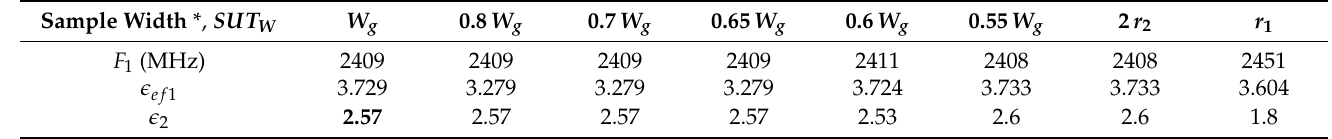
Table 5. Analyzing resonant frequencies for constant sample length ( SUT L = 2 ( r 2 + g + 1 ) ) and variable sample width, SUT W .